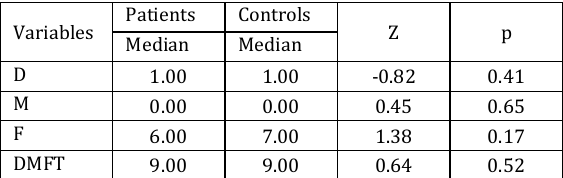
Table 1. The number of D, M, F teeth, and DMFT index in patients and controls